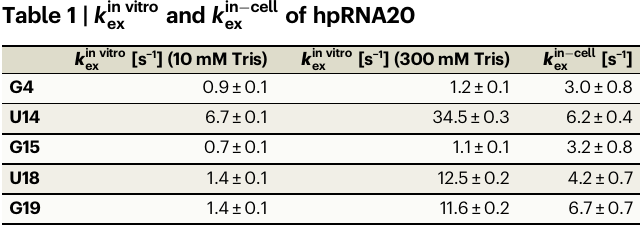
Table 1 | k in vitro